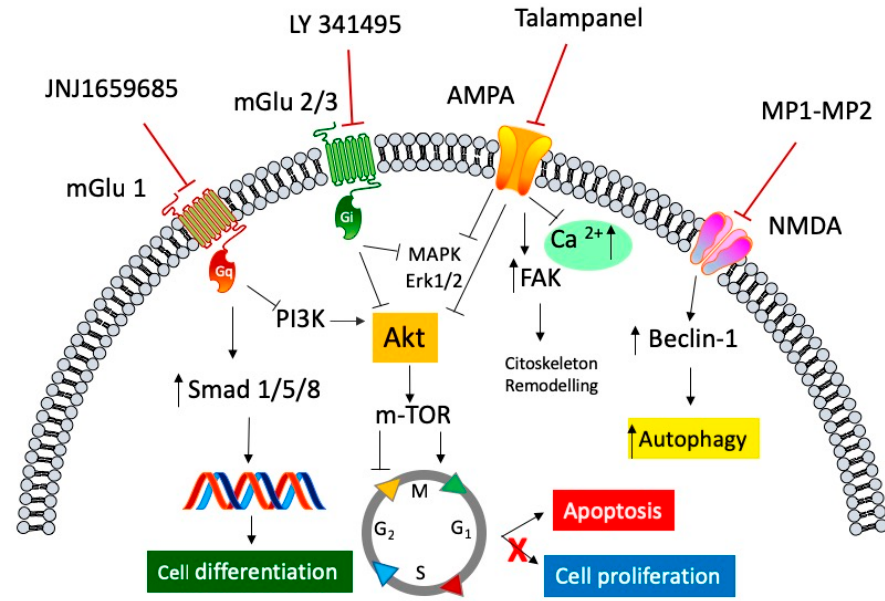
Figure 1. General representation of the signaling pathways involved in the antagonism of both ionotropic and metabotropic glutamate receptors in anti-cancer mediated e ff ects. Selective metabotropic glutamate receptor 1 (mGluR1) antagonist JNJ1659685 elicited its anti-cancer activity, by decreasing cell proliferation, through the inhibition of the phosphoinositide 3-kinase / protein kinase B (PI3K / Akt) pathway, and by increasing cell di ff erentiation through the activation of the transcription factors small mother against decapentaplegic transcription factor (Smad) 1 / 5 / 8. LY 341495, an mGluR 2 / 3 selective antagonist, blocks the activation of both the mitogen-activated protein kinase (MAPK) / extracellular signal-regulated kinase (ERK)1 / 2 cascade and the Akt / mammalian target of rapamycin protein (mTOR) pathway, resulting in arrest of the cell cycle and an increase in apoptosis. Talampanel, a selective negative allosteric α -amino-3-hydroxy-5-methyl-4-isoxazole propionic acid (AMPA) modulator, inhibits the rise of intracellular calcium concentration, and inhibits both ERK1 / 2 and Akt phosphorylation, slowing down the cell proliferation, and increasing cellular sti ff ness through the activation of focal adhesion kinase (FAK) protein. The N -methyl- d -aspartate (NMDA) antagonists, MP1 and MP2, two memantine derivative compounds, exert their antiproliferative activity by modulating Beclin-1 binding protein, which increases the autophagic processes of glioblastoma cell line.